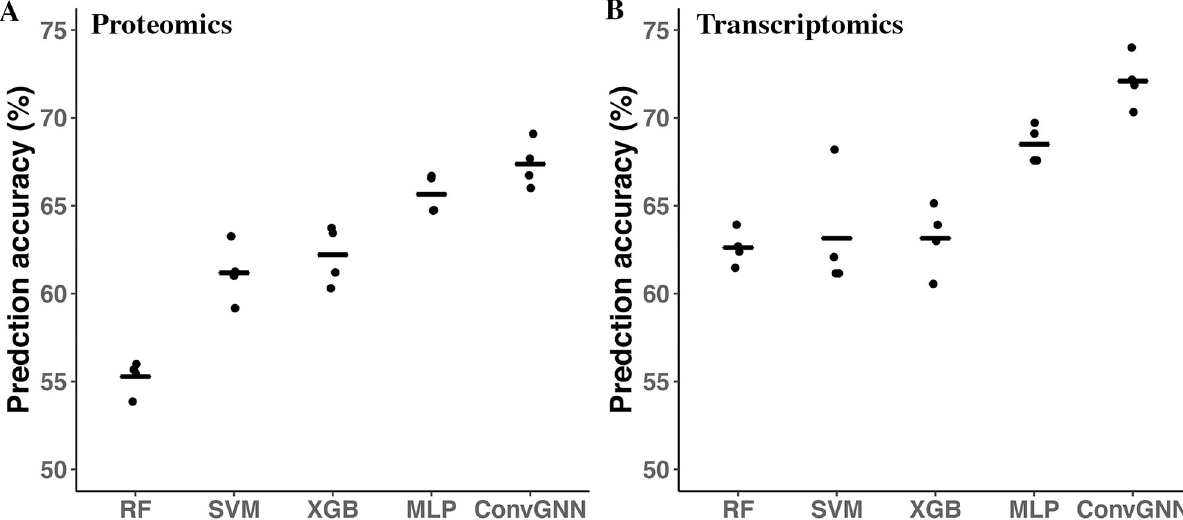
Fig 2. Convolutional Graph Neural Network performance on single omics data. The ConvGNN models were trained in a 4-fold CV strategy with single omics data: proteomics data (A) or transcriptomics data (B). The STRING PPI network was used for the graph convolution. Four other classification methods were also evaluated: RF, SVM, XGB, and MLP. The model performances are assessed using the prediction accuracies on the testing dataset. The lines represent the mean accuracies for CV-trained models and the error bars represent the standard error of the mean.